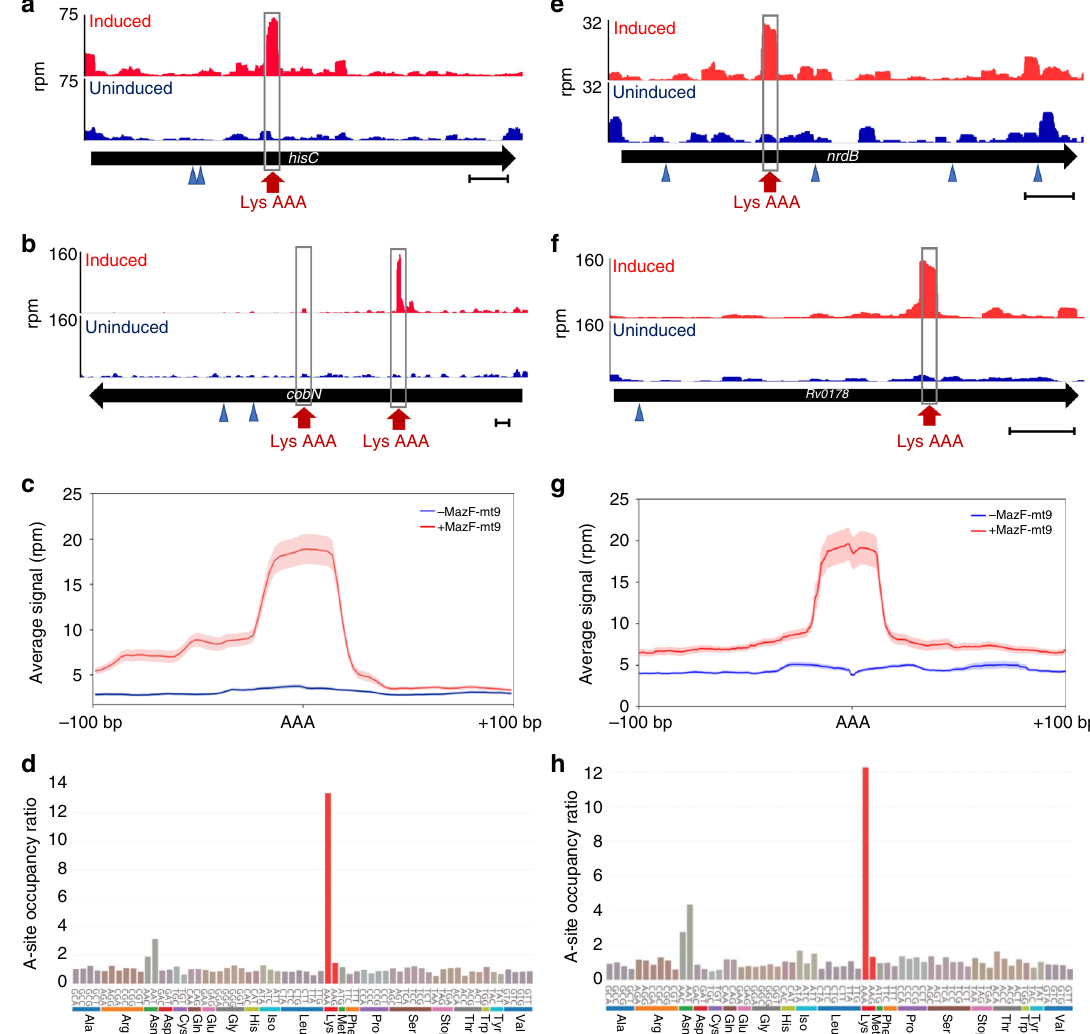
Fig. 3 Ribo-seq con fi rms transcriptome-wide AAA Lys-speci fi c ribosome stalling. a , b , e , f Ribo-seq read coverage in reads per million (rpm) of AAA Lys- containing M. smegmatis ( a , b ) or M. tuberculosis mc 2 6206 ( e , f ) transcripts in ±MazF-mt9 cells (arrows indicate direction of translation). The location of in-frame AAA Lys codons and out-of-frame AAAs are indicated (red arrow/gray box and blue arrow head, respectively). Scale bars illustrate a 100 bp genomic distance. c , g , Average read counts (rpm) of mapped ribosomes surrounding AAA Lys codons in + MazF-mt9 (red line) or -MazF-mt9 (blue) cells; light shading represents the standard deviation. d , h Ratio of codon occupancy (MazF-mt9 induced vs. uninduced) at the predicted ribosomal A-site position identi fi ed in the mapped ribosomal footprints, grouped by amino acid or stop codon. Source data for d and h are provided in a separate tab